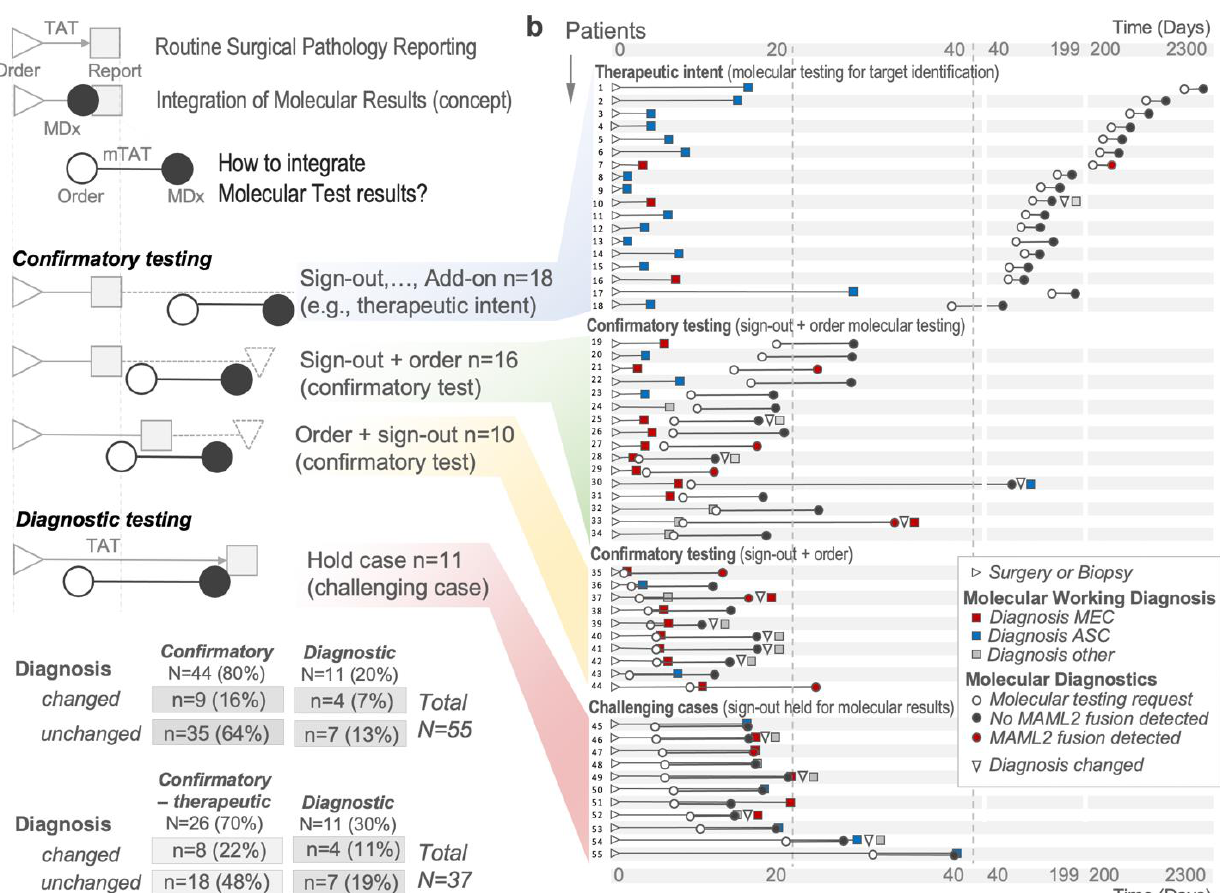
Figure 2. Molecular–genetic diagnostic test results integration. The generation of a diagnosis from a tissue sample relies on the interpretation carried out by the surgical pathologist. To follow the concept of integrating molecular diagnostics, the time of molecular testing (mTAT) needs to be considered. To perform molecularly informed decision-making to support the correct diagnosis, the molecular result must be available before surgical pathology sign out. Integration of molecular test results into the surgical pathology diagnosis results in several scenarios. ( a ) To obtain a diagnosis, the tissue specimen is submitted to the surgical pathologist and will be analyzed in a certain turn-around time (TAT). ( b ) Time points of surgical pathology and molecular order and surgical pathology and molecular sign-out for patients. Red squares represent the working diagnosis MEC, blue squares represent the working diagnosis ASC, and grey squares indicate another working diagnosis. White circles represent the time point of the molecular testing request, red circles show a detected MAML2 rearrangement, and blue circles indicate a negative (no MAML2 rearrangement) result. White horizontal triangles indicate the time point of surgical pathology order and are normalized to 0, and white vertical triangles mark a changed surgical diagnosis after molecular testing. ( c ) In a confirmatory intent, molecular testing is usually ordered right before or shortly after the case is diagnosed (signed out). ( d ) When confirmation of a diagnosis requires molecular diagnostics, the case is held until the molecular result is available to the surgical pathologist. Light grey squares indicate the final diagnosis, white circles mark molecular test ordering, and black circles show molecular testing results. ( e , f ) Four-field tables with cases represented according to their order intent (confirmatory vs. diagnostic) and whether their final diagnosis was changed due to molecular testing. Abbreviations: MDx, molecular diagnostics; mTAT, molecular turn-around time; TAT, turn-around time.